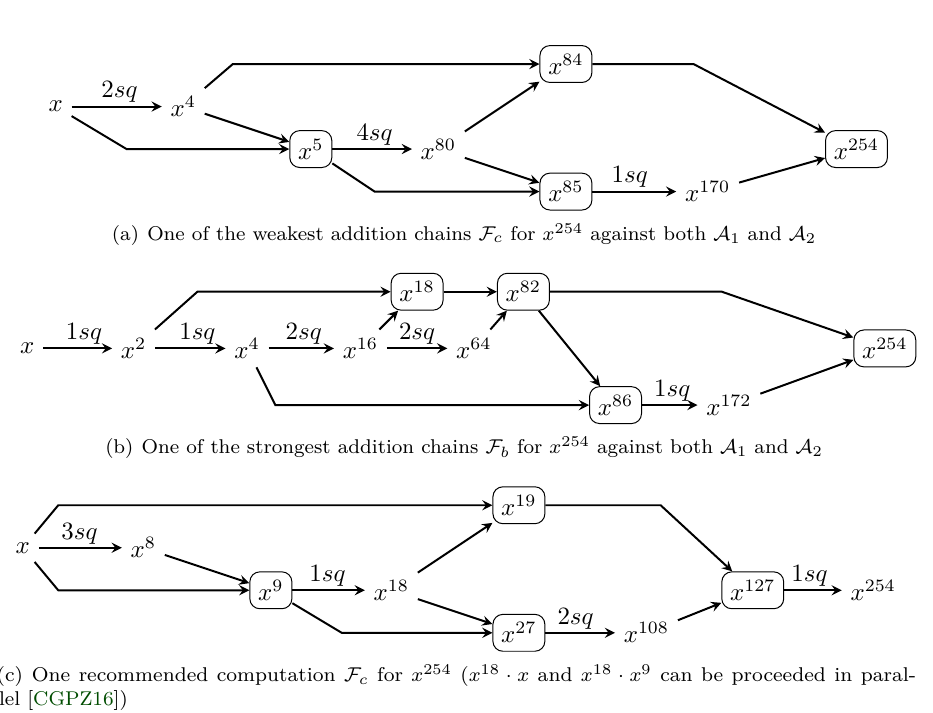
Figure 6: Three typical addition chains, and they are with the highest efficiency for AES S-box implementation (4 multiplications and 7